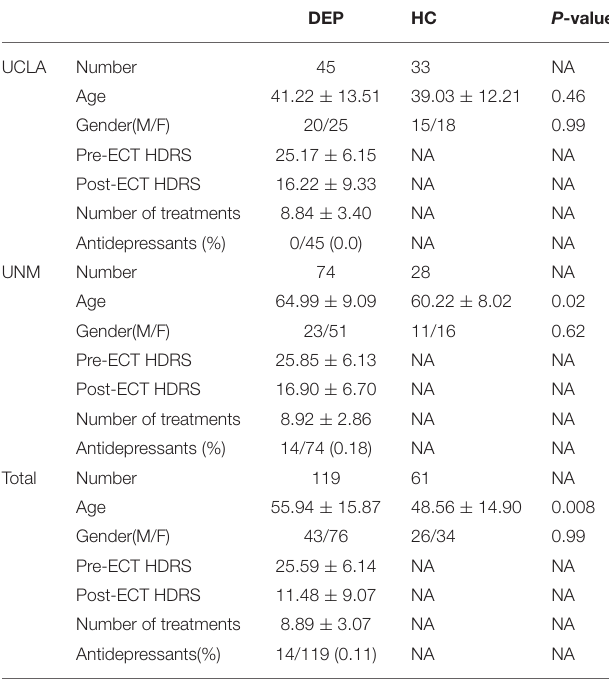
TABLE 1 | Demographic and clinical details of the participants for each